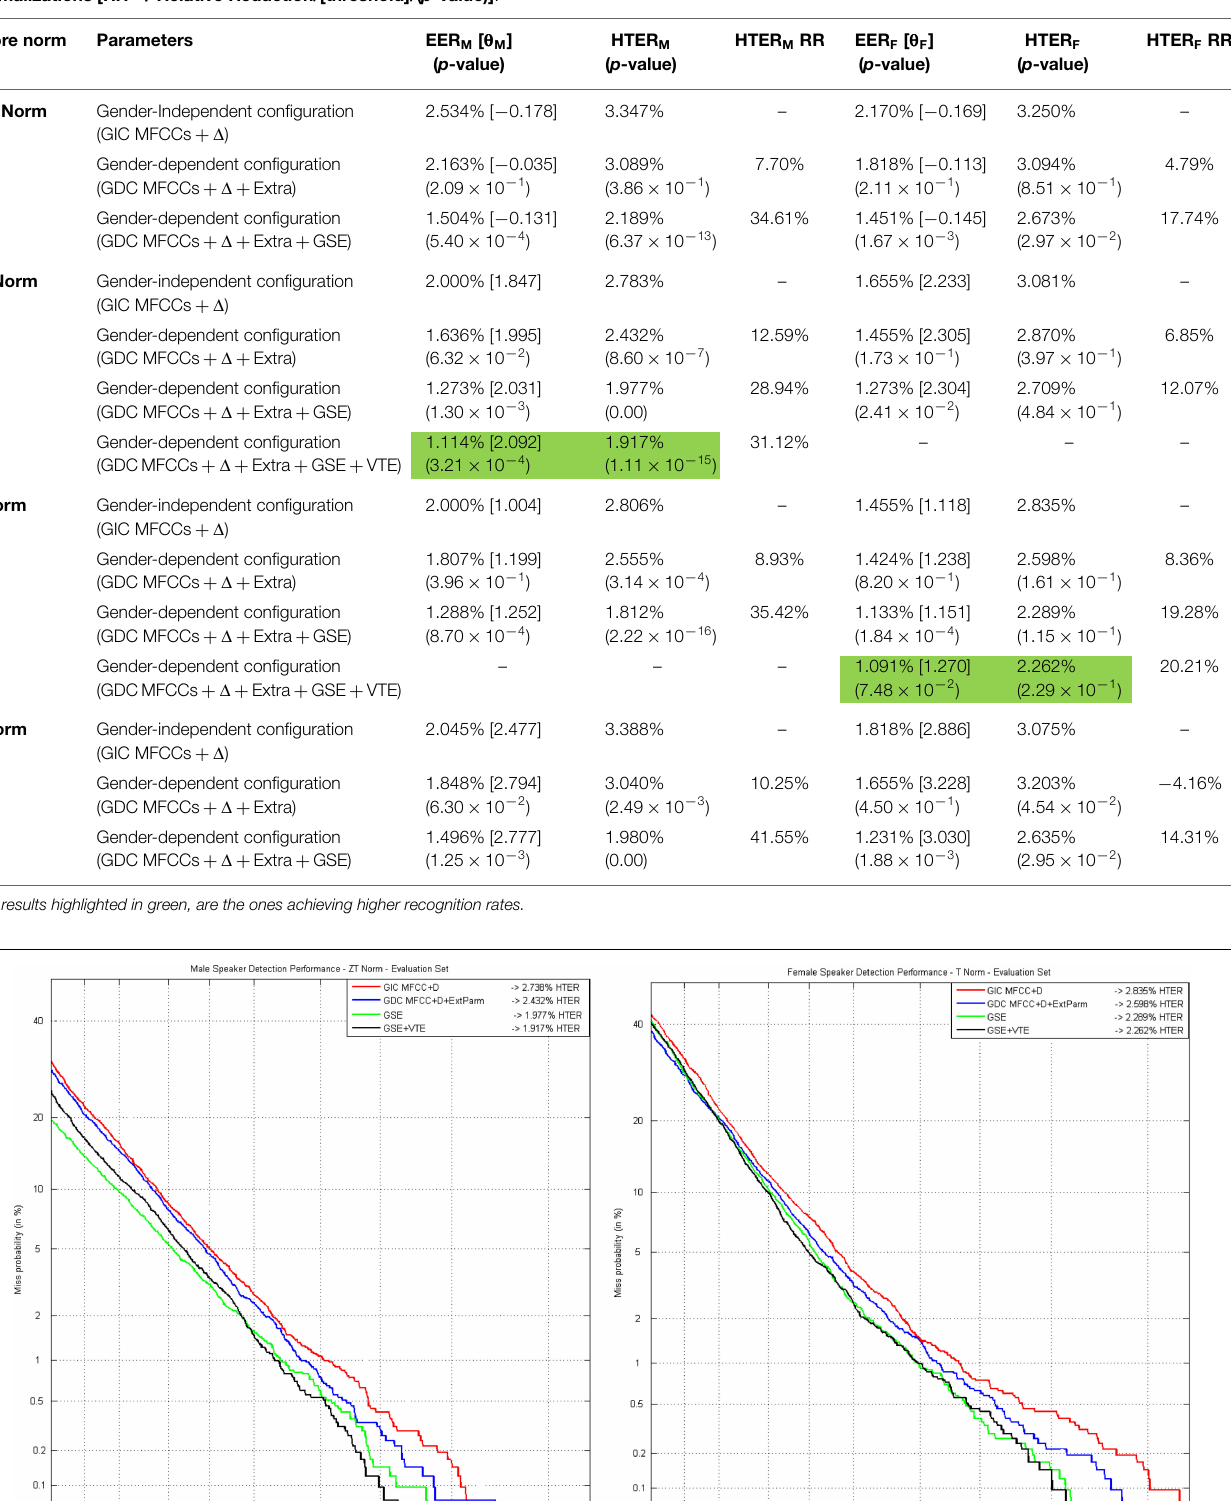
TABLE 4 | HTER X on evaluation set, obtained for configurations providing the most successful results on development set, applying different score normalizations [RR !!! Relative Reduction/[threshold]/( p -value)] . Score norm